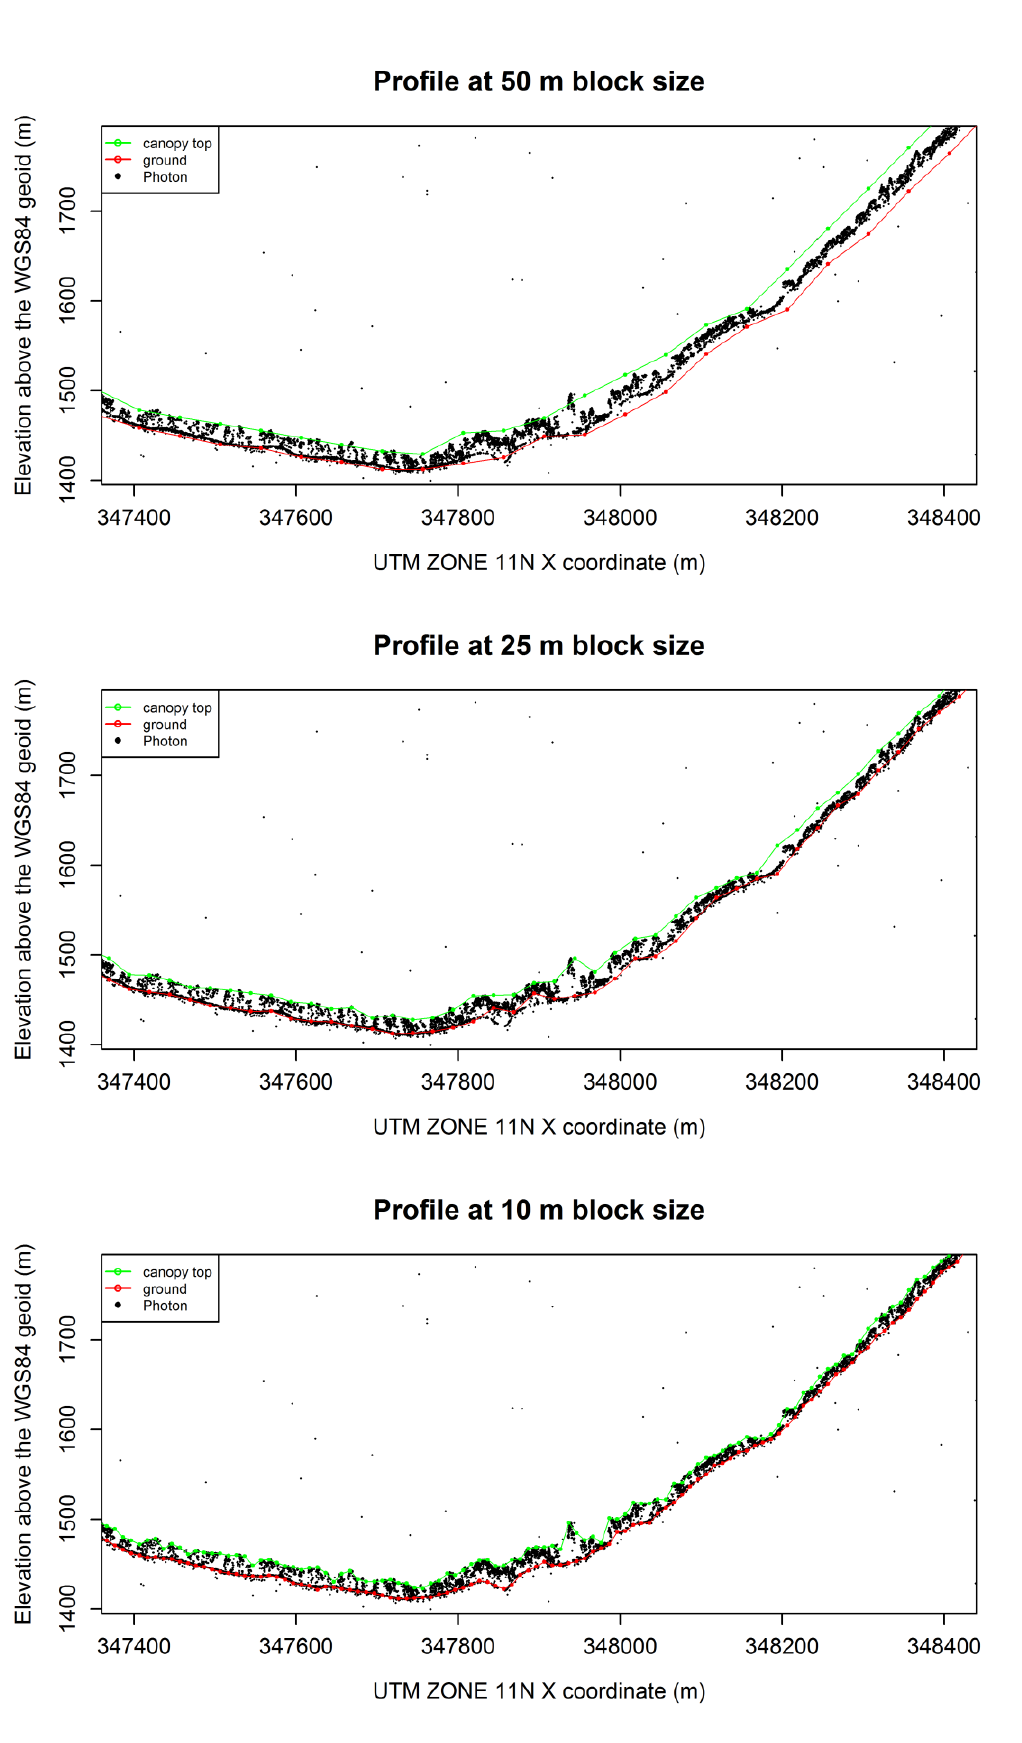
Figure 4. Examples of profiles at different bock sizes from a 1 km stretch of transect